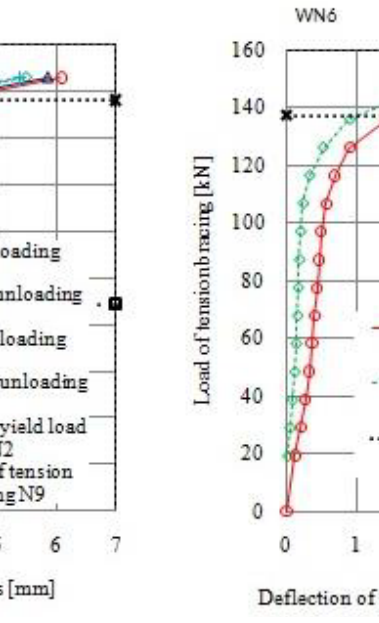
Figure 10: Load-deflection diagram for joint WN6 ( β = 0,6)